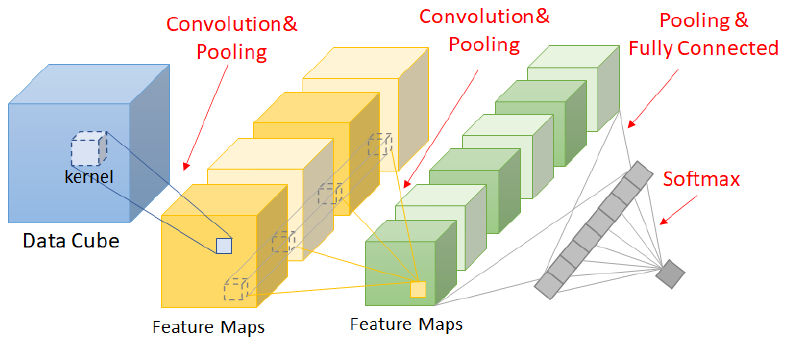
Figure 3. Three-dimensional convolutional neural